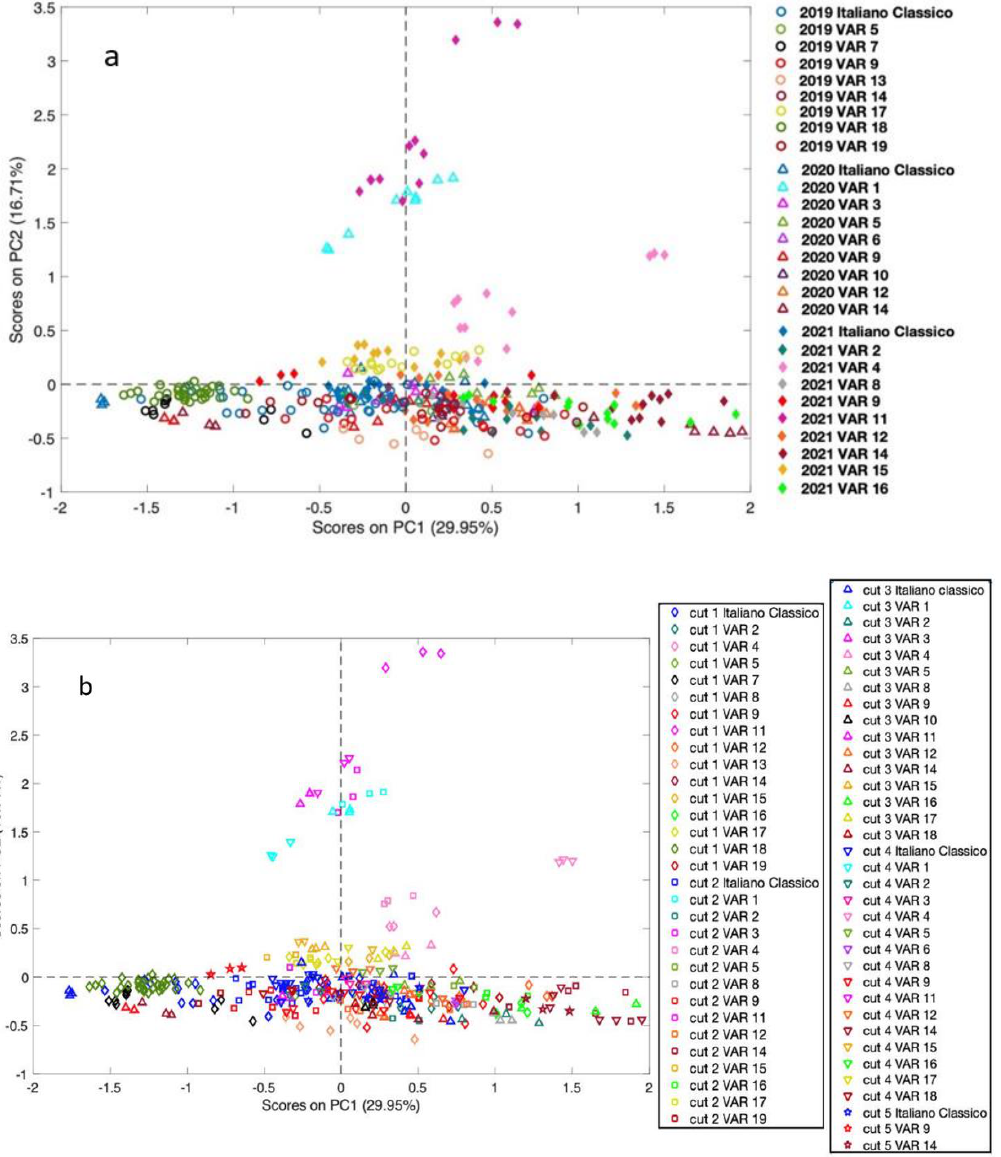
Figure 2. PC1 vs. PC2 score plots of basil samples. ( a ) Different symbols are used for each harvesting year (2019: circles; 2020: squares; 2021: triangles) and different colors for each basil variety. ( b ) Different symbols are used for each cut (first: diamonds; second: squares; third and fourth: upwards and downwards triangles, respectively; fifth: stars) and different colors for each basil variety.